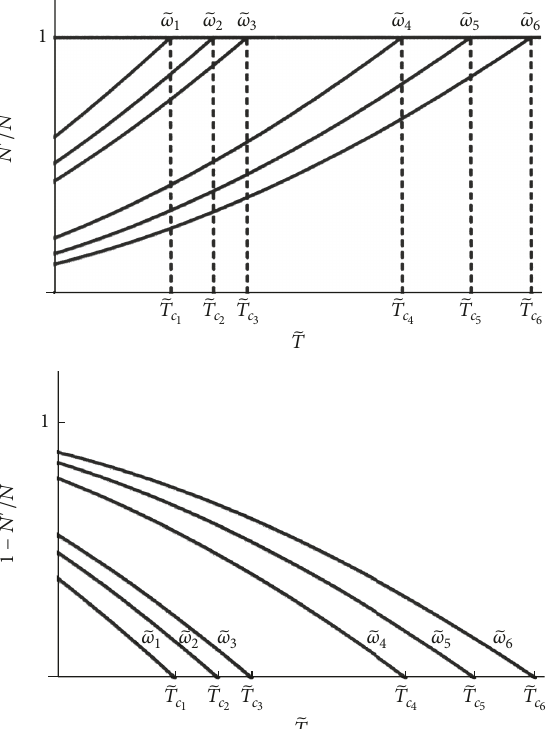
Figure 3: Temperature dependencies of the relative number of supracondensate particles 𝑁 󸀠 /𝑁 and the particles occurring in the condensate 𝑁 0 /𝑁 = 1 − 𝑁 󸀠 /𝑁 for the parameter values ̃𝜔 𝑖 , given in Figure 2.